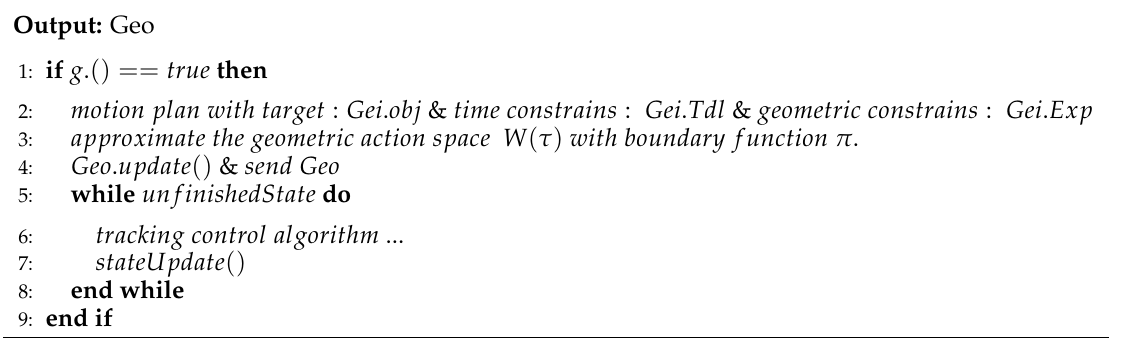
Algorithm 4 Action primitive algorithm ap